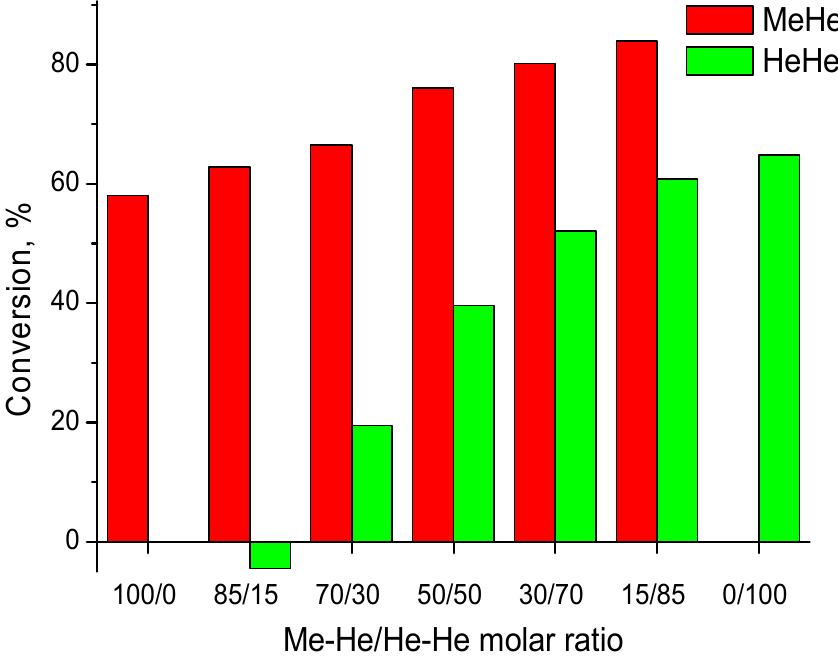
Figure 7. The simultaneous conversion of MeHe and HeHe in their mixture over 1CuZn catalyst. The total amount of esters (MeHe + HeHe) taken for the reaction—0.69 mol, m cat = 1.5 g, T reac. = 210 ◦ C, p H2 = 100